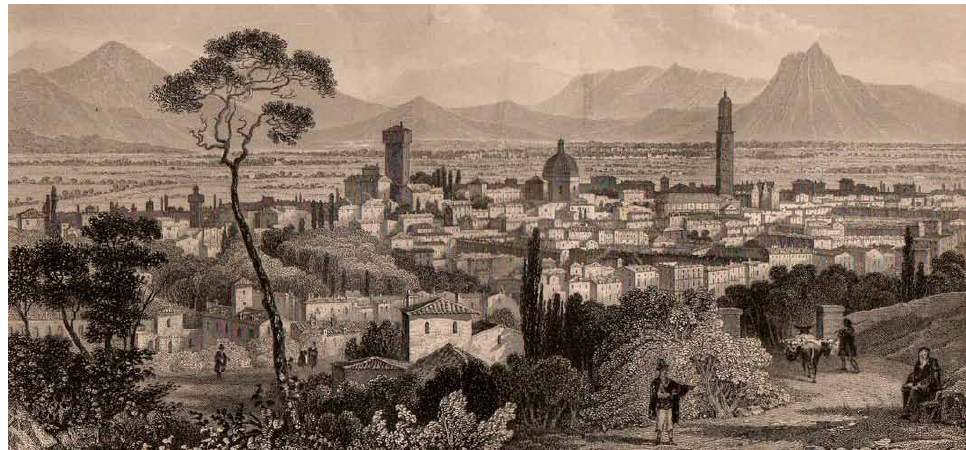
fig. 1. View of Vicenza from the Berici Hills, work of the artist William Cooke Stafford in